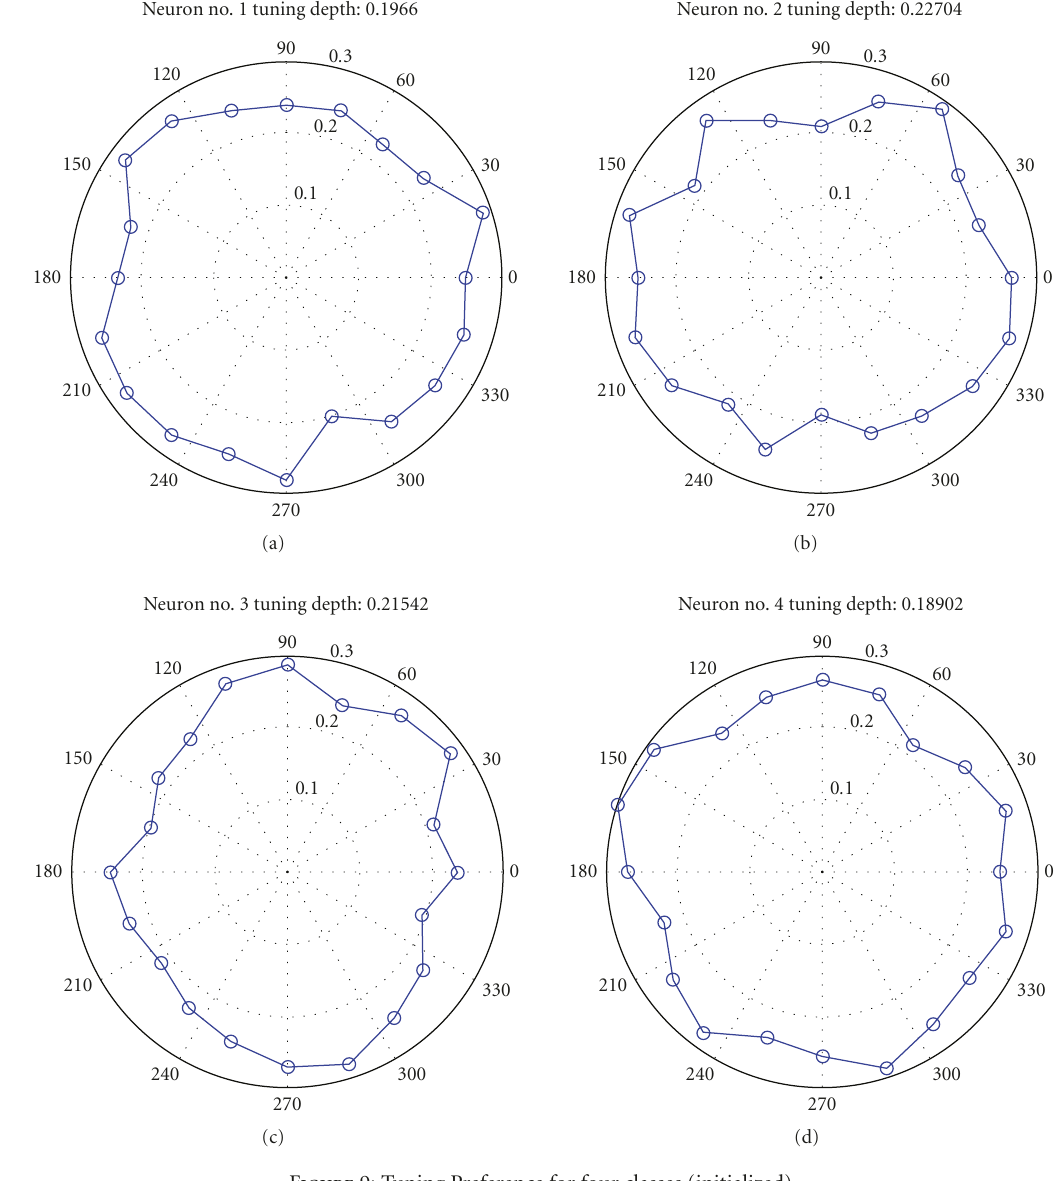
Figure 9: Tuning Preference for four classes (initialized).